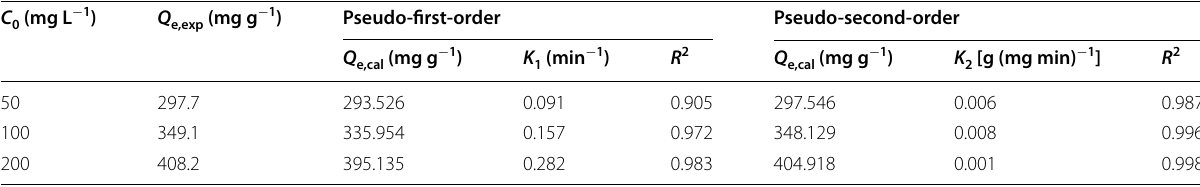
Table 5 CR kinetic adsorption fitting parameters